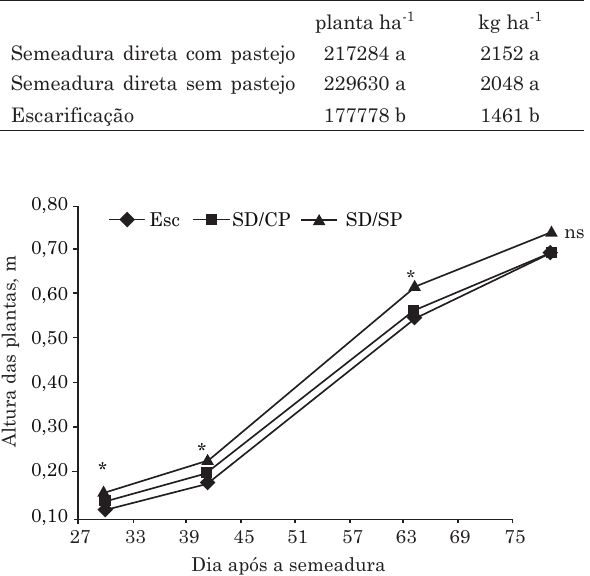
Figura 3. Variação da altura das plantas de soja ao longo do ciclo no manejo escarificado (ESC), na semeadura direta sem (SD/SP) e com pisoteio animal